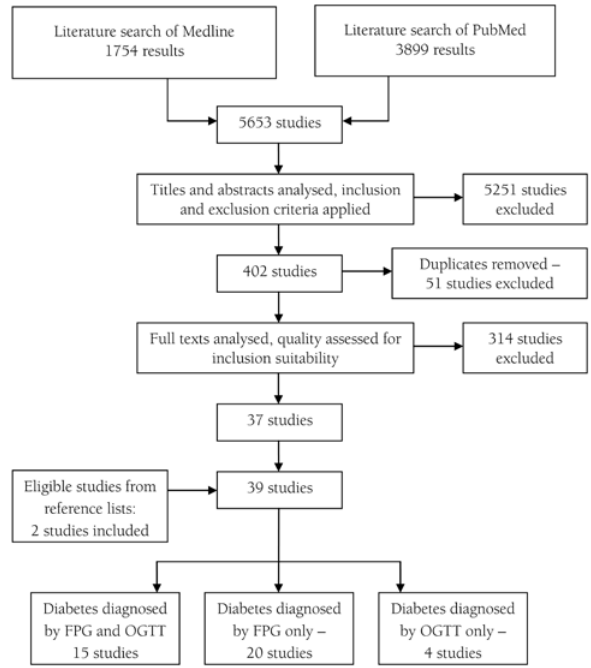
Figure 1. Study selection process. FPG –fasting plasma glucose, OGTT –oral glucose tolerance